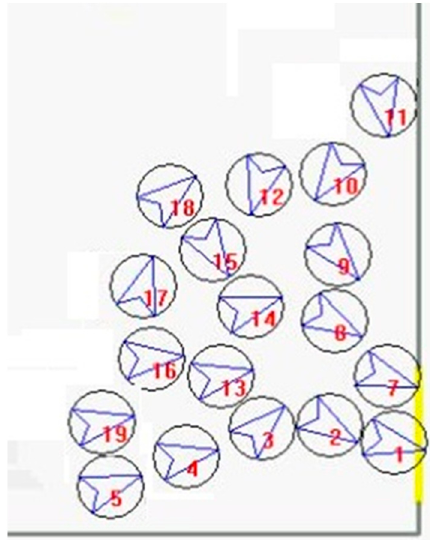
Figure 30. Line chart of outlet flow.